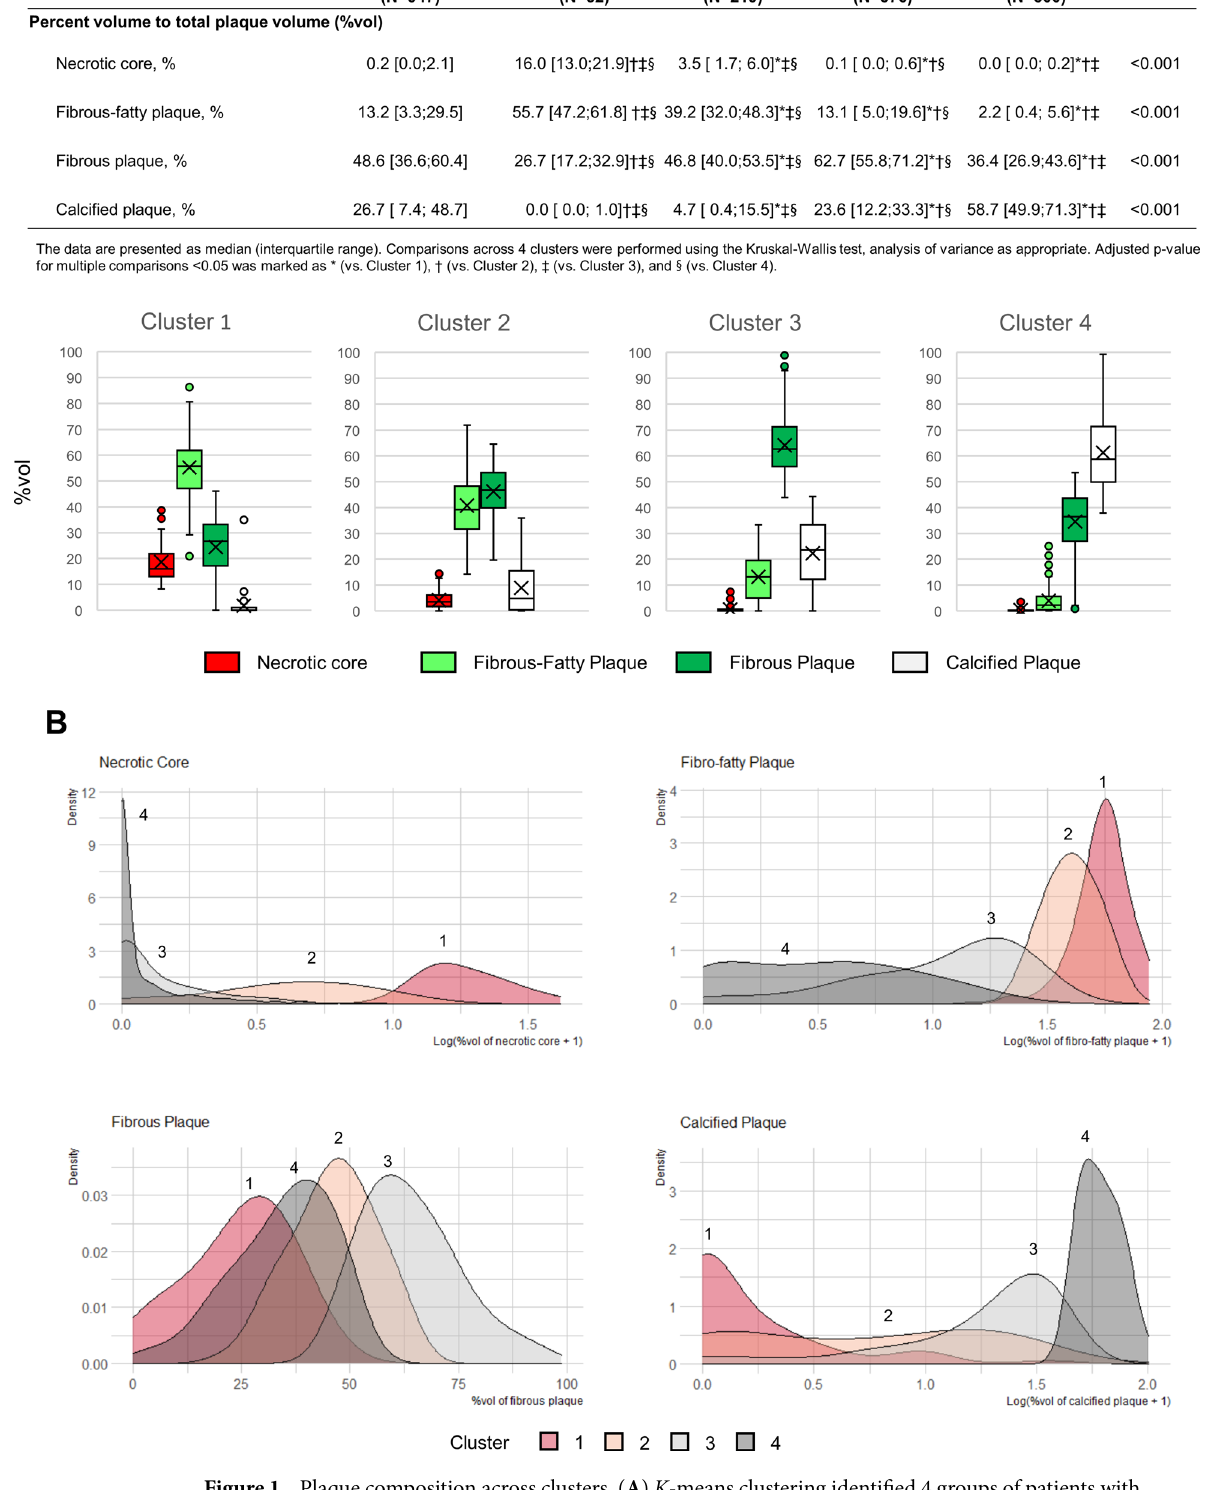
Figure 1. Plaque composition across clusters. ( A ) K -means clustering identified 4 groups of patients with different plaque composition. ( B ) Density plots showing the distribution of the percent volume (%vol) of each plaque